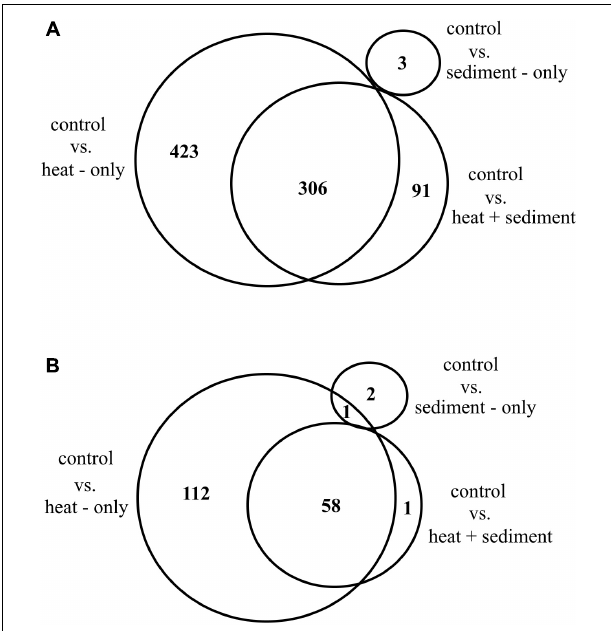
FIGURE 3 | Venn diagram showing overall number of differentially expressed transcripts (DETs) from RNA-Seq analysis which are shared and specific to three different treatment comparisons: control vs. heat-only, control vs. heat + sediment and, control vs. sediment-only (A) ; and number of DETs with unique protein matches that are shared and unique for each of the treatment comparison (B)